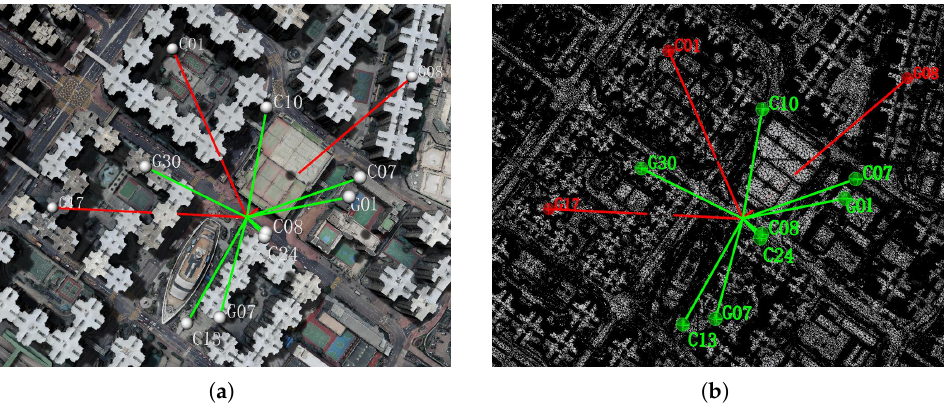
Figure 15. Modeling results in Rhino. ( a ) Rendering mode. ( b ) Coloring